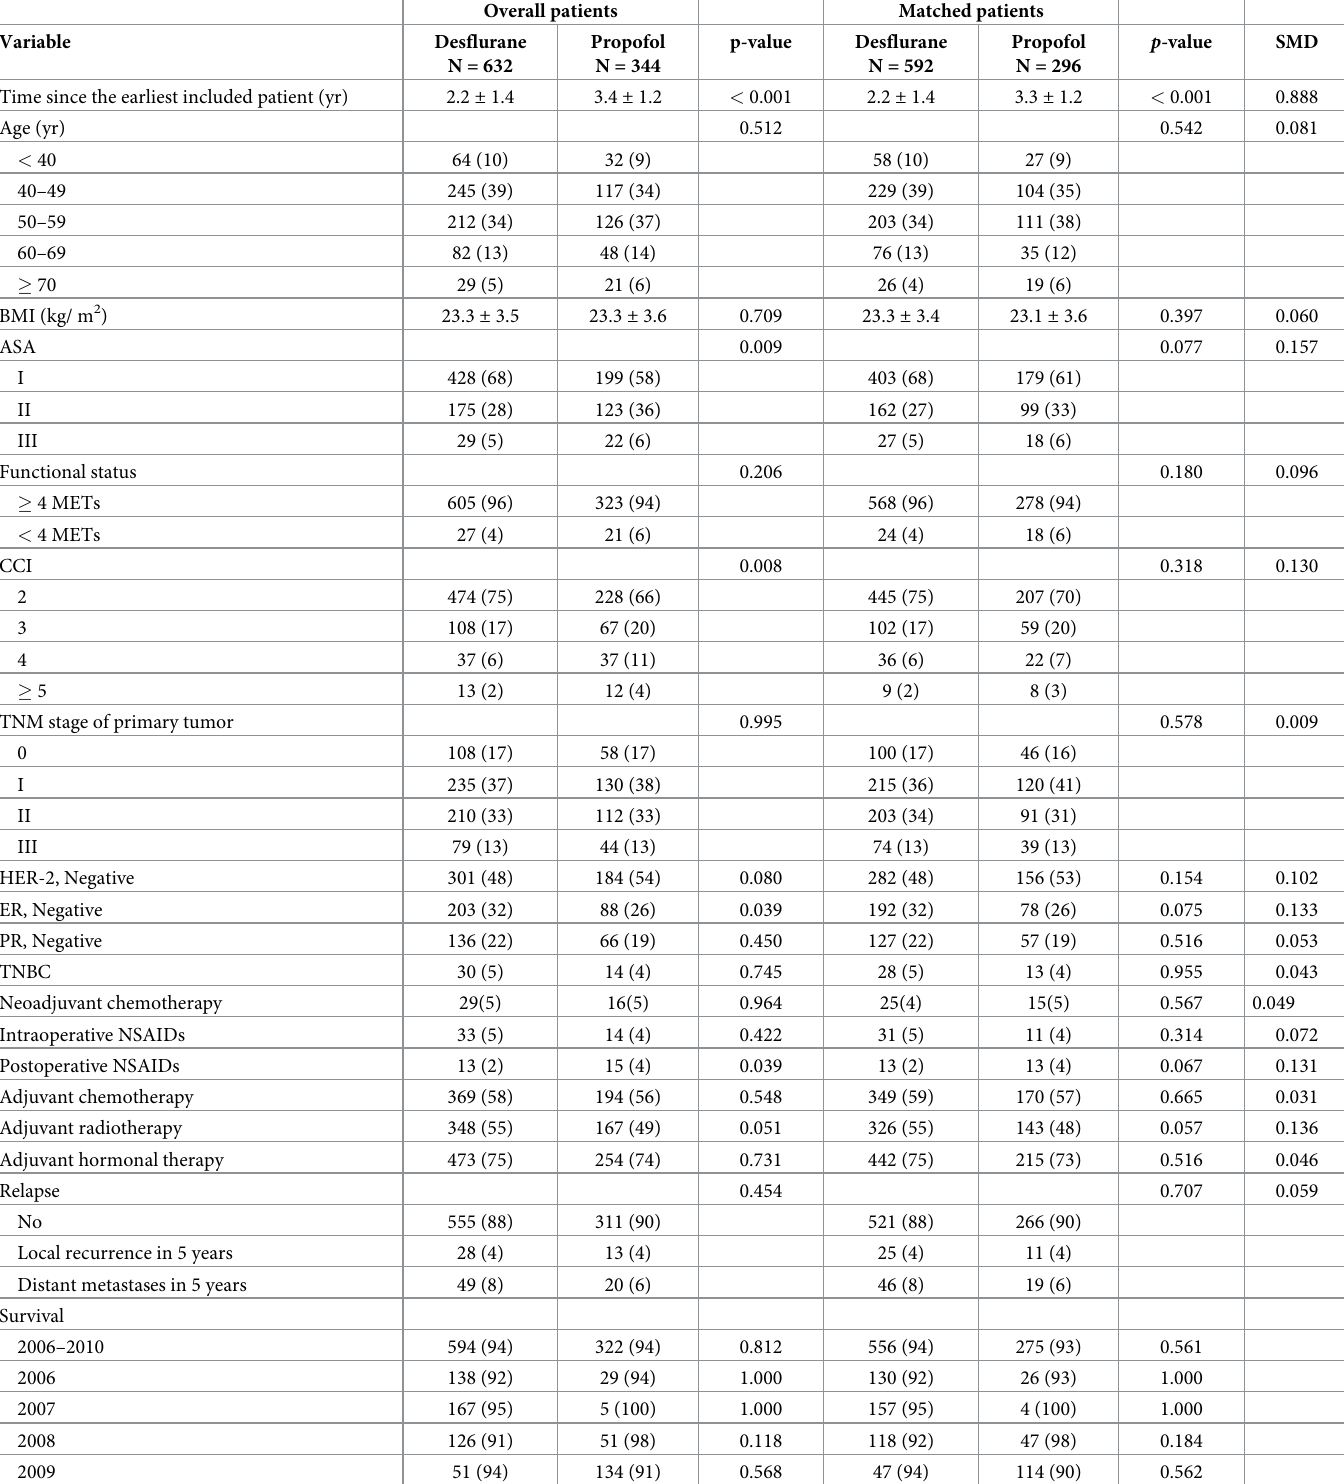
Table 1. Patient and treatment characteristics for overall patients and matched patients after propensity